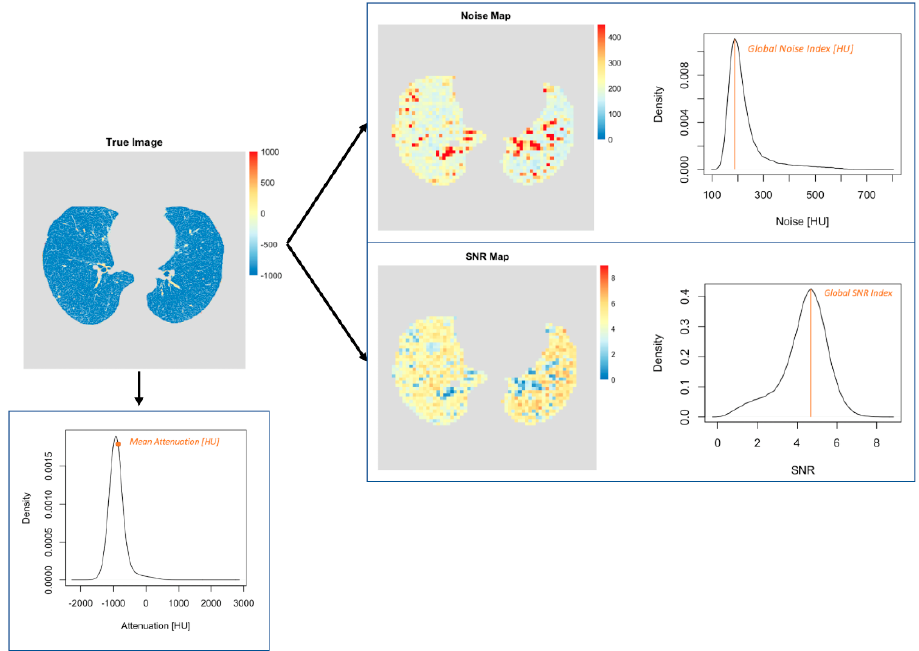
Figure 1. Visual representation of the quantitative image analysis in patients. First, the lungs were segmented automatically from the CT image sets. Second, mean CT attenuation was measured. Third, noise and signal-to-noise ratio maps were generated. The mode values of the corresponding distributions were defined as GNI and GSNRI .